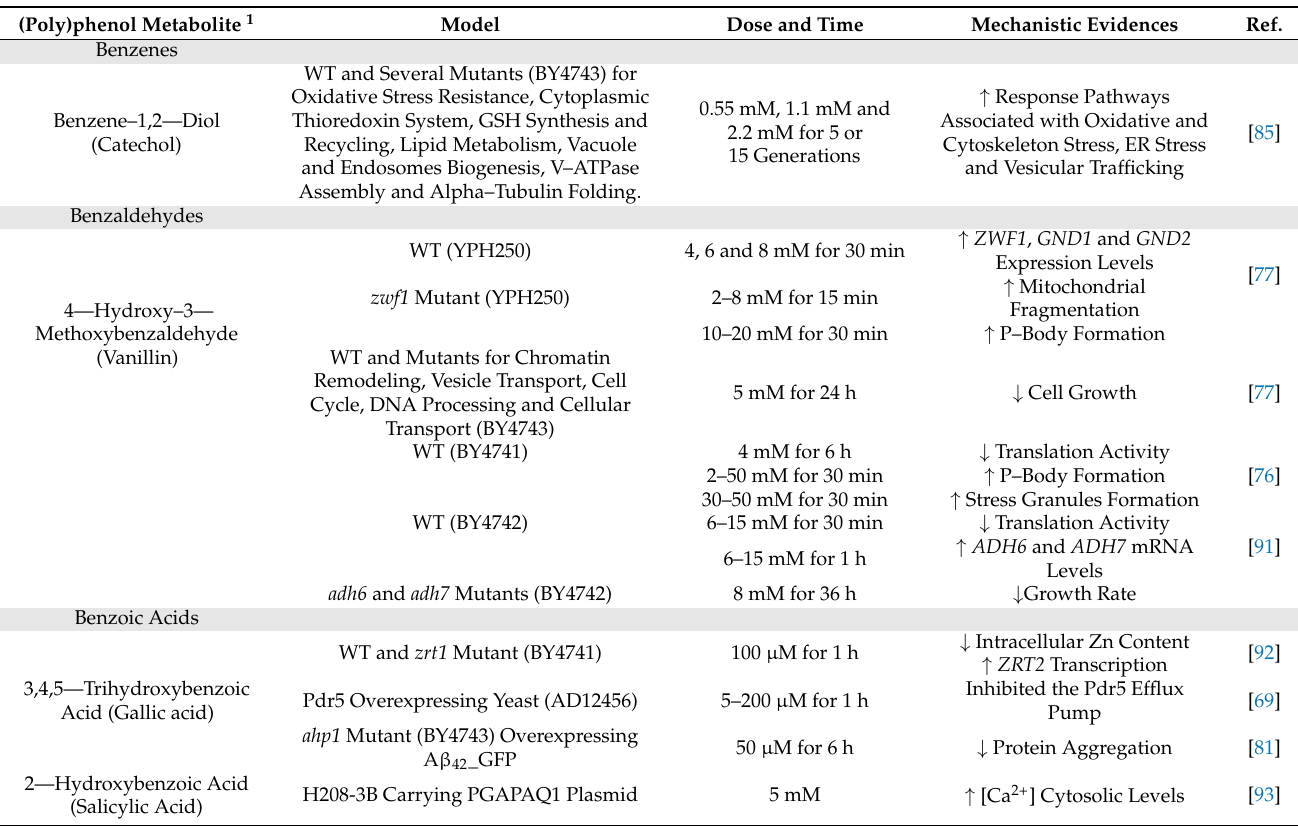
Table 1. Effects of low molecular weight (poly)phenol metabolites on the indicated hallmarks of NDDs in Saccharomyces cerevisiae . (Poly)phenol Metabolite 1 Model Dose and Time Mechanistic Evidences